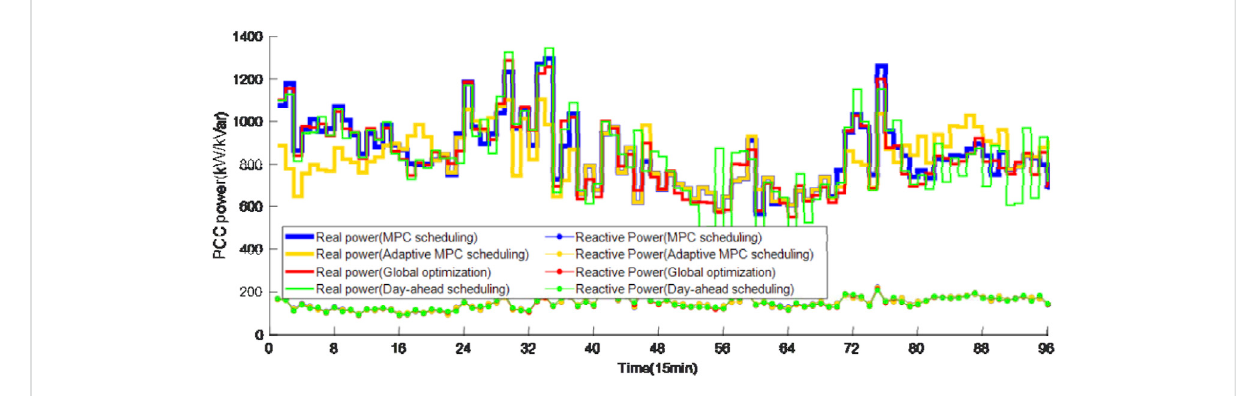
FIGURE 15 PCC power curves under different scheduling